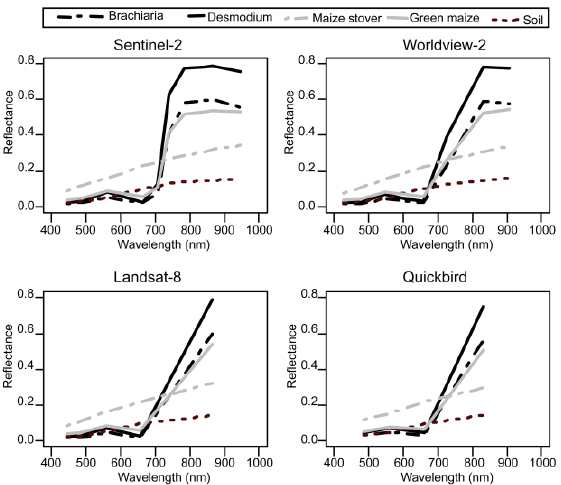
Figure 3. Mean canopy spectra of the ‘push-pull’ system components using the band configuration of four multispectral